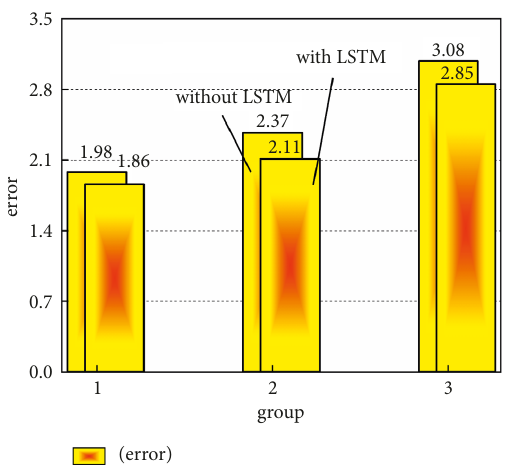
Figure 4: The prediction errors of factors related to market eco- nomic development using with and without the LSTM method.